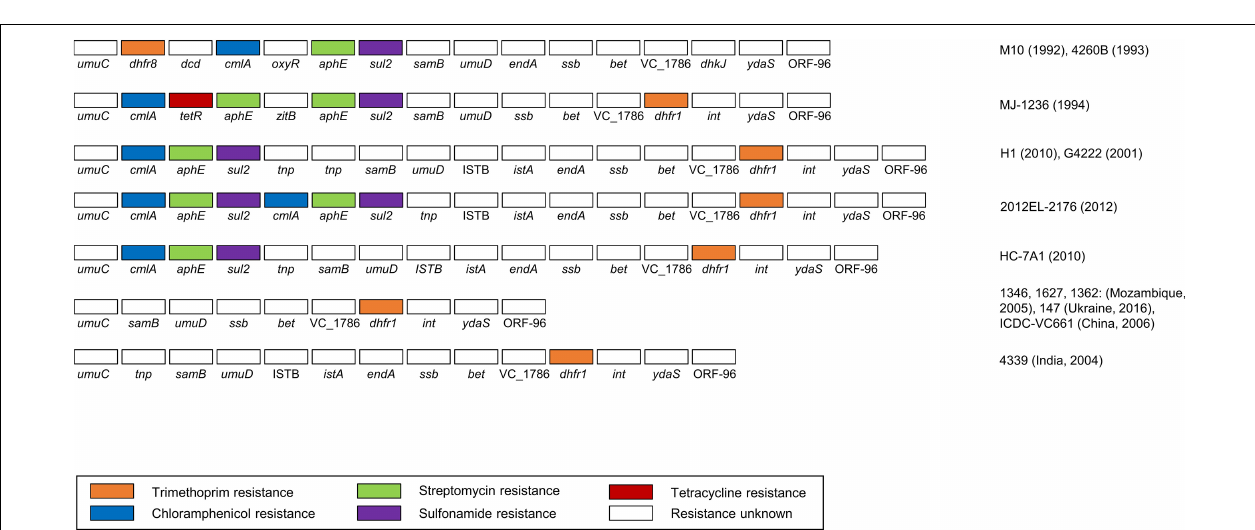
FIGURE 4 | The trend of antibiotic resistance of V. cholerae . A total of 21 drug classes were predicted. The drugs in the “others” category include aminocoumarin, cephamycin, glycylcycline, streptogramin, triclosan, cephalosporin, glycopeptide, nucleoside, rifamycin, tetracycline, monobactam, macrolide, and aminoglycoside.